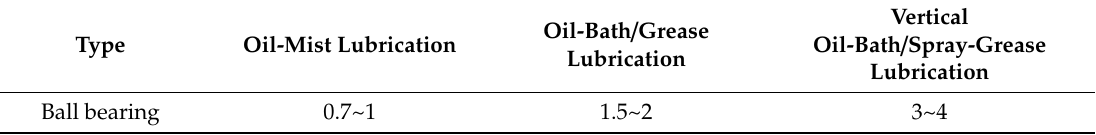
Table 2. Value of coe ffi cients related to bearing type and lubrication method with di ff erent lubrication types.